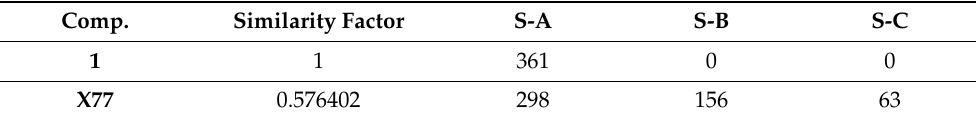
Table 3. Fingerprint similarity between jusan coumarin and X77 . Comp. Similarity Factor S-A S-B